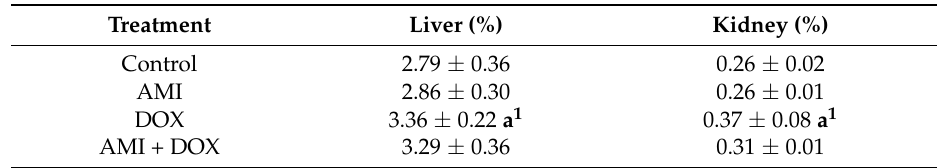
Table 1. The influence of amifostine and/or doxorubicin on relative (%) liver and kidney weight of the rats 4 weeks after receiving the last treatment.